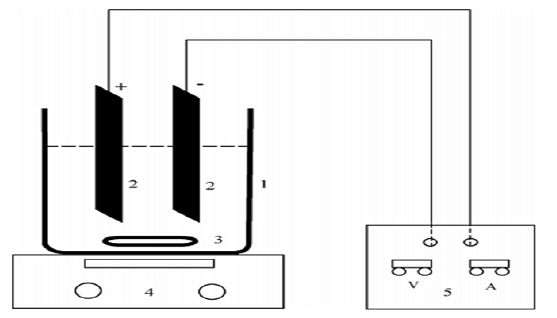
Fig. 1. Schematic process arrangement. (1) Chemical beaker ; (2) mild steel electrode pair; (3) magnetic stirrer bar; (4) magnetic stirrer; (5) dc power supply (V, voltage regulator and A, current regulator) EC process current density (A/m 2 ) and time of